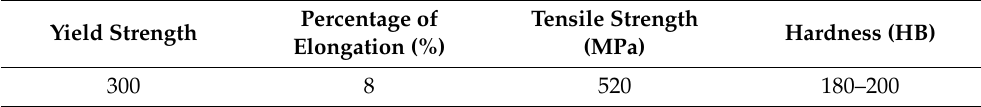
Table 3. Mechanical characteristics of ductile cast iron.